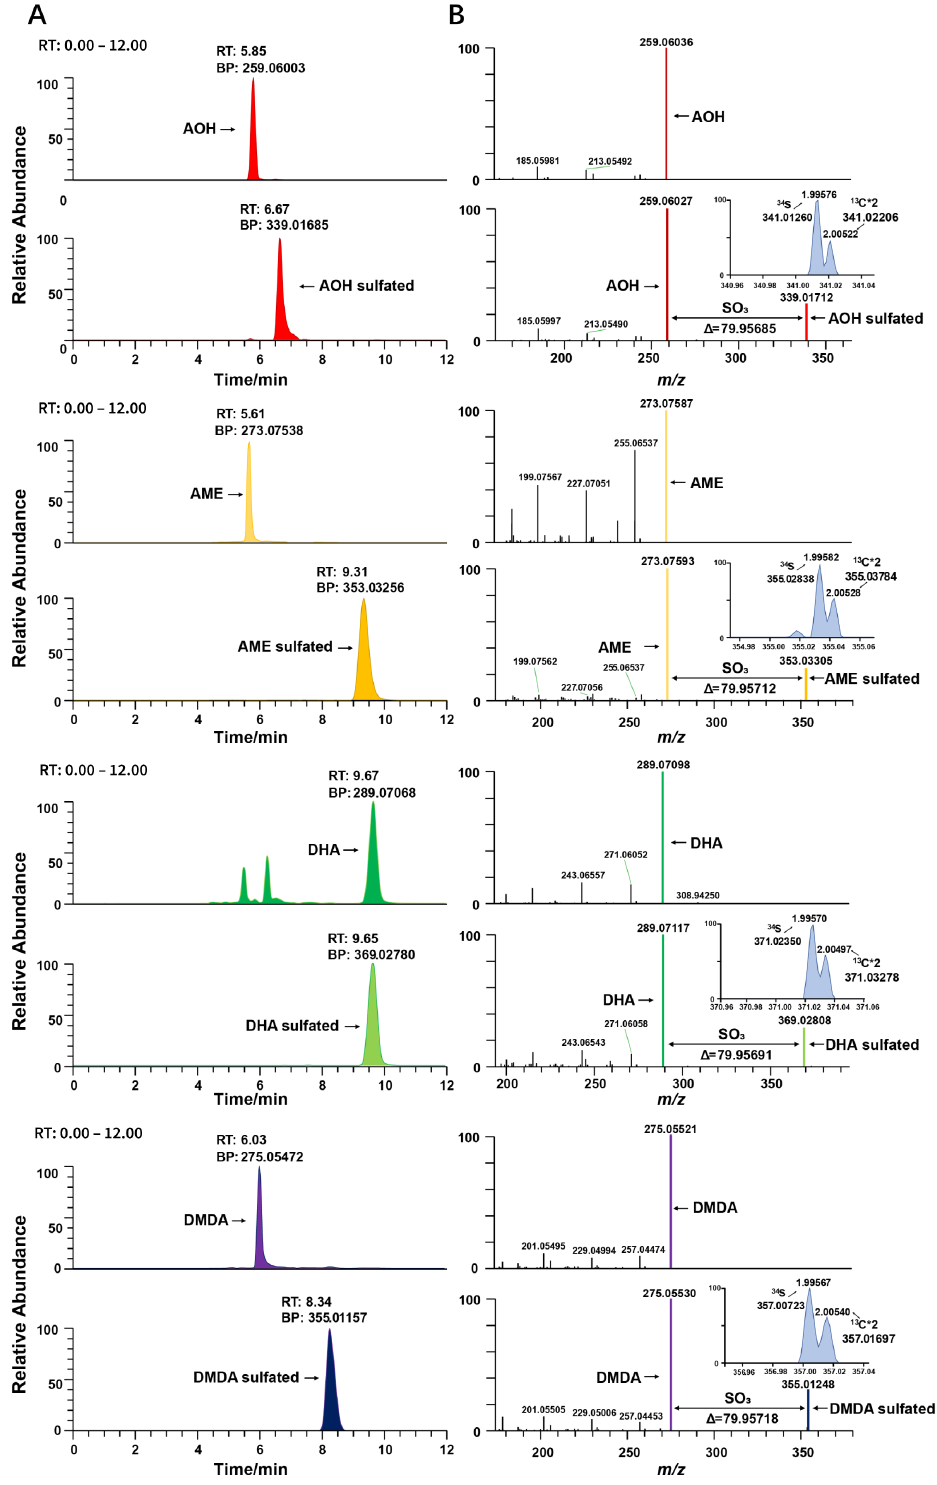
Figure 3. Example of detection of sulfate conjugated mycotoxin. ( A ) Chromatograms of sulfated and unsulfated mycotoxins. ( B ) Spectra of sulfated mycotoxins with neutral loss of SO 3 ( 79.9568 Da ± 5 ppm ) and isotope peak of 34 S (1.995 Da).